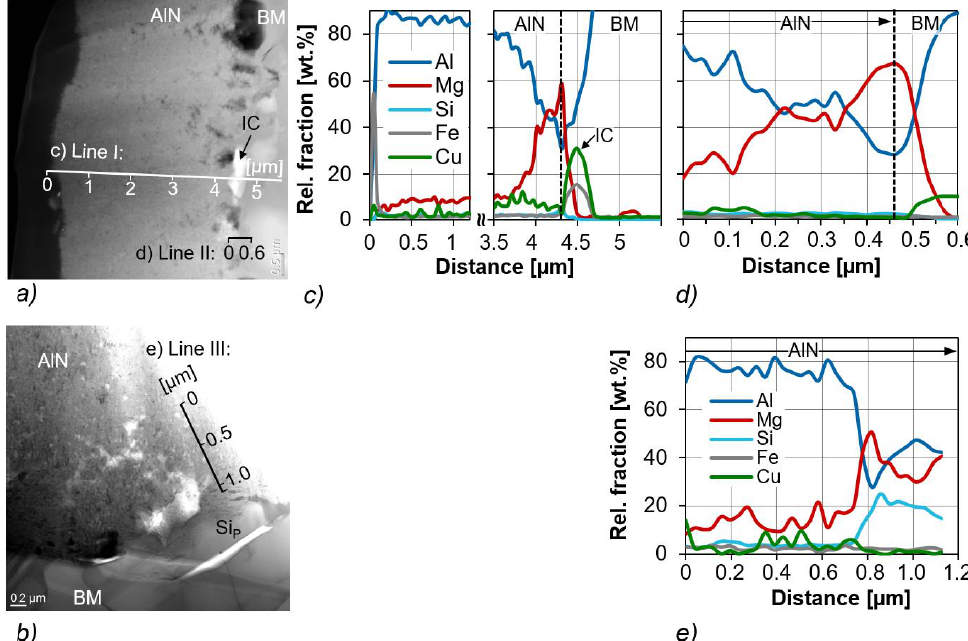
Figure 4. TEM investigations by means of a nitride layer with a thickness of t AlN ≈ 4.3 µm: ( a,b ) overview of the cross sections (df) investigated with the positions of the EDS measuring lines, and EDS profiles measured without nitrogen and oxygen (dotted line: interface) for: ( c ) EDS line I: over the total nitride layer thickness with an intermetallic compound (IC) at the interface; ( d ) EDS line II: at the interface area without intermetallic compounds; ( e ) EDS line III: at the interface area with primary silicon Si p in the base material BM.